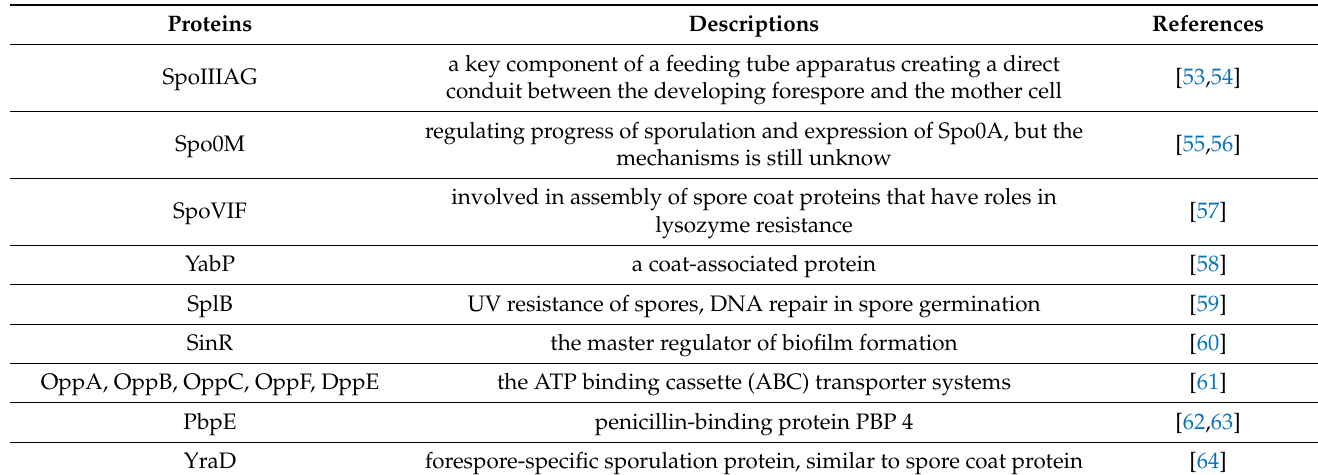
Table 4. Proteins enriched in the Uniprot term of